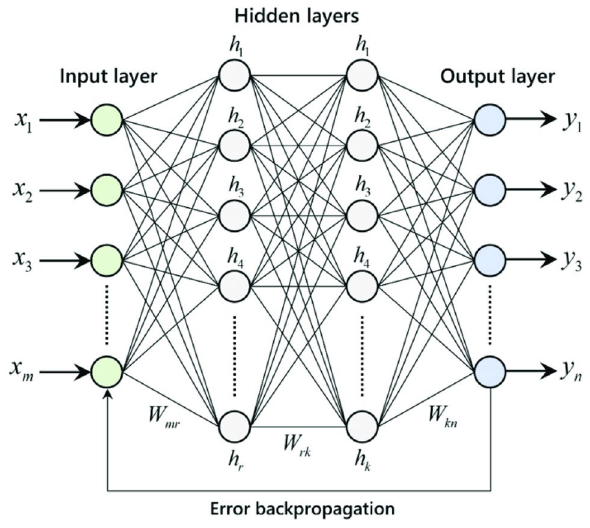
Figure 1. A multilayer perceptron ANN graph alongside inputs and outputs